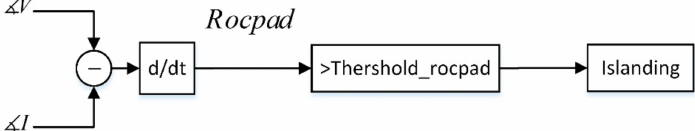
Figure 3. Islanding detection using rate of change of phase angle di ff erence (ROCPAD)